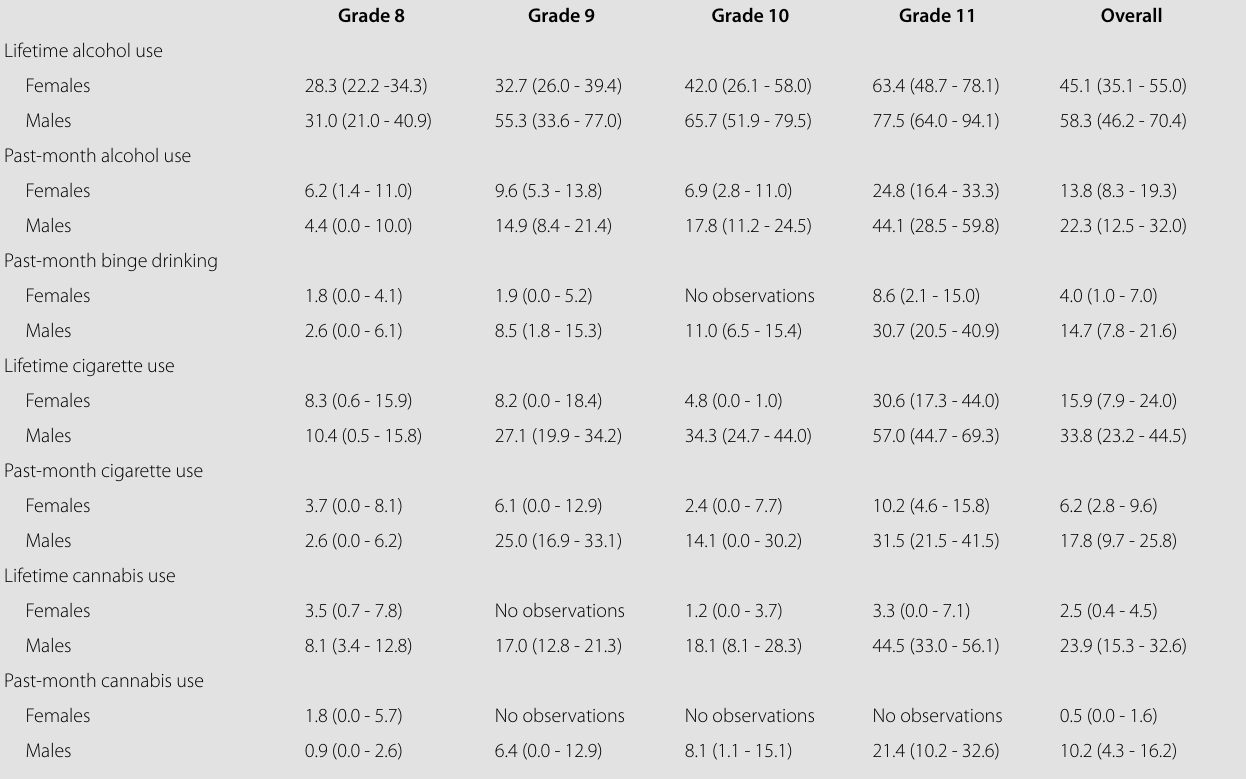
Table 2. Prevalence rates (% (95% CI)) of alcohol, cigarette and cannabis use, by grade and